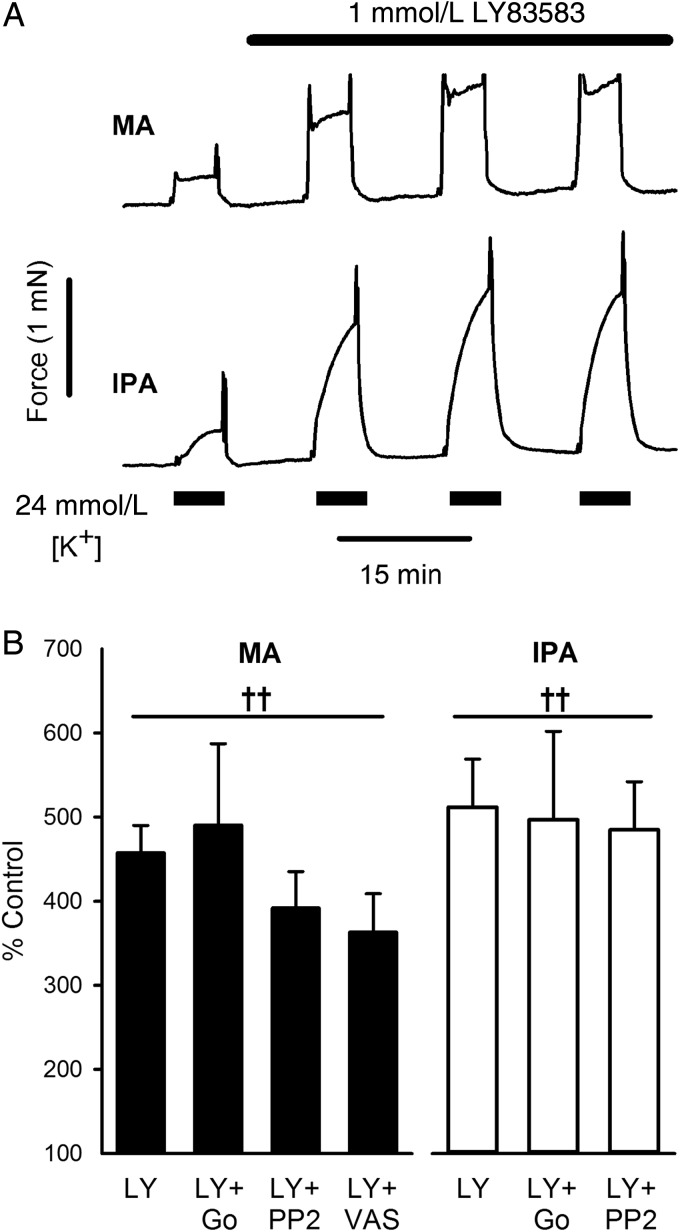
The ROS generator LY83583 mimics the effect of SPC. (A) Typical tension recordings from rat MA and IPA for 5 min challenges with PSS containing ∼25 mmol/L [K+] and following addition of 1 µmol/L LY83583, showing potentiation of the response. (B) LY83583 (LY)-induced potentiation at 30 min in 9 MA (5 rats) and 9 IPA (5 rats), and in the presence of Go6983 (Go, 4 MA and 4 IPA), PP2 (11 MA and 8 IPA), and VAS2870 (VAS, 6 MA); 18 rats. Bars = SEM. ††P < 0.001 vs. control (no LY83583); no inhibitor had any significant effect; one-way ANOVA, Holm-Sidak post hoc.